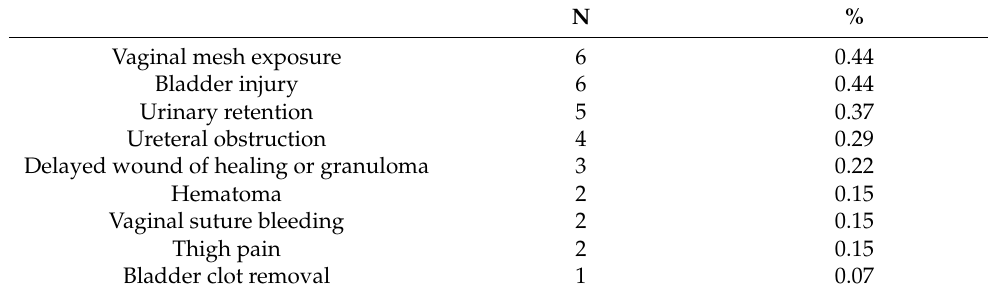
Table 4. The list of Clavien–Dindo grade IIIa or higher complications and their frequencies (n =